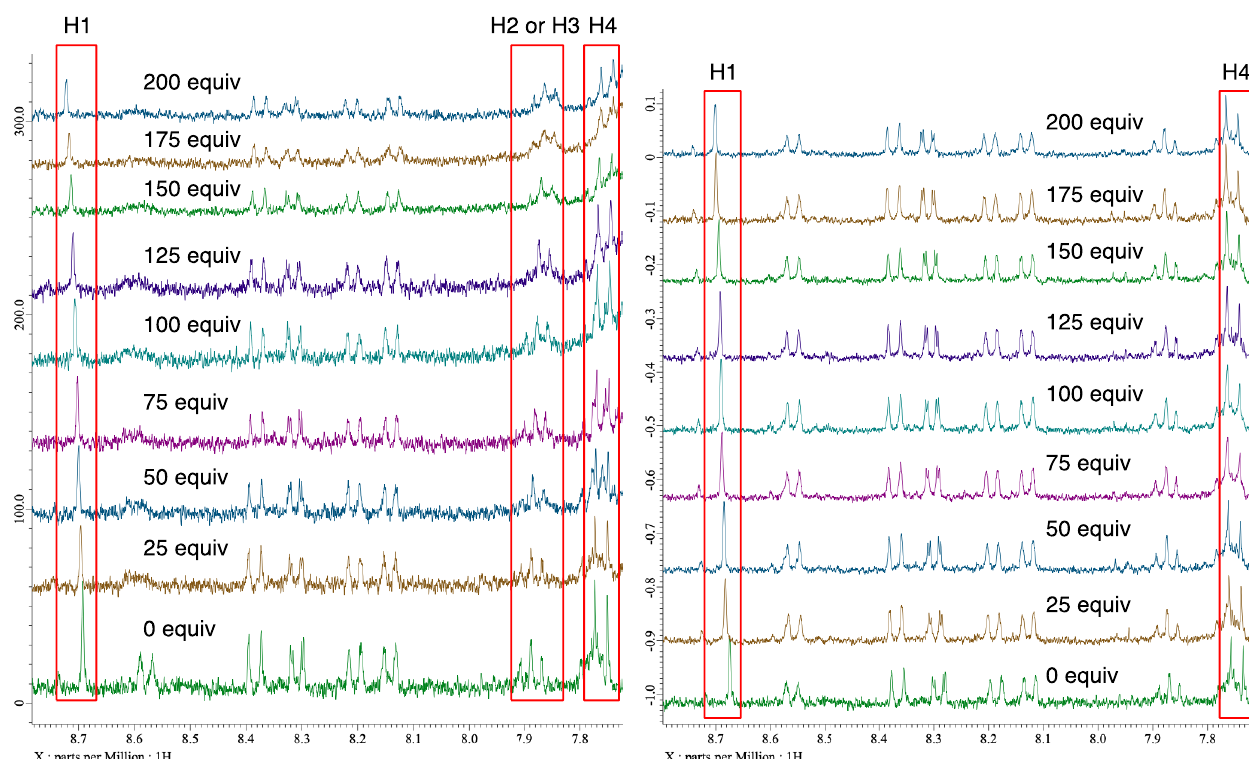
Figure 4. 1 H NMR charts (in CDCl 3 ) of 4a with different equivalents of 5a ( left ), and 6a ( right ).